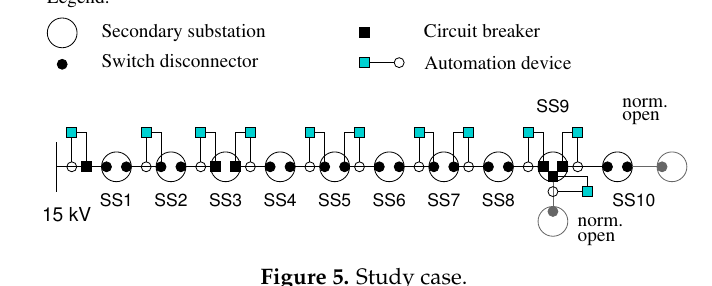
Figure 5. Study case. Table 3. Study case loads and